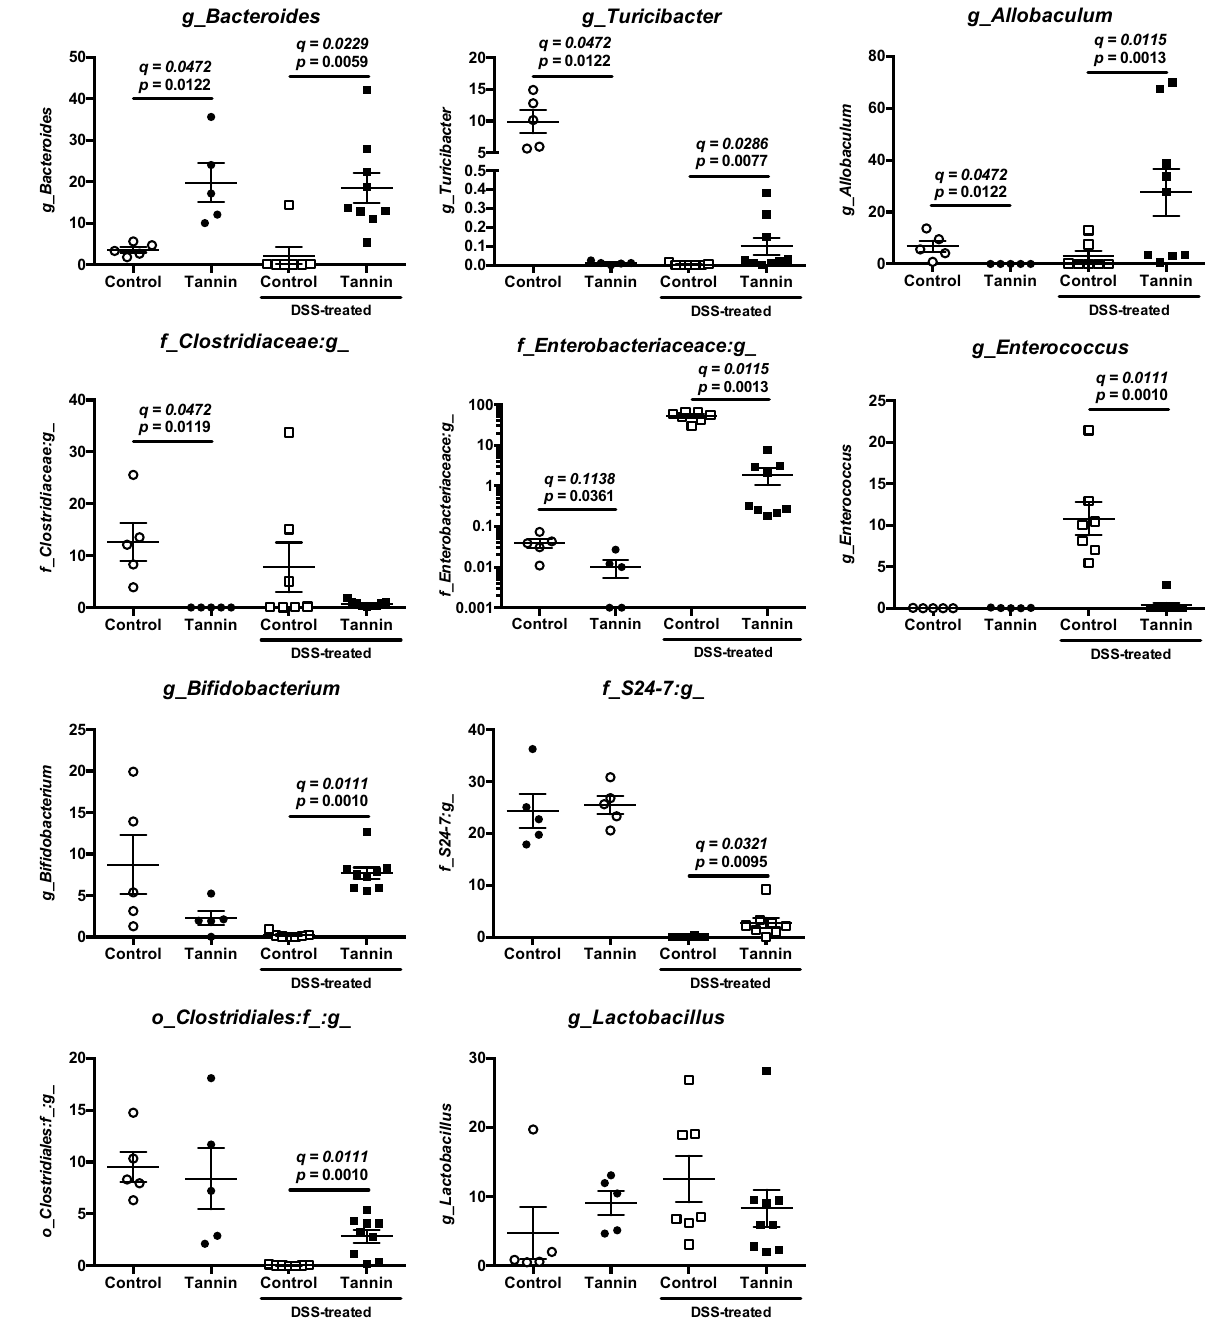
Figure 6. Dietary supplementation of persimmon-derived tannin suppresses expansion of potentially pathogenic bacteria in DSS-induced colitis. Relative abundances of 10 genera that were most contributed to dissimilarity of faecal microbiota in the untreated and DSS-treated mice fed the control or tannin-supplemented diet were shown as the mean ± SEM with individual plots (n = 5–9). Q-value is an FDR-adjusted p